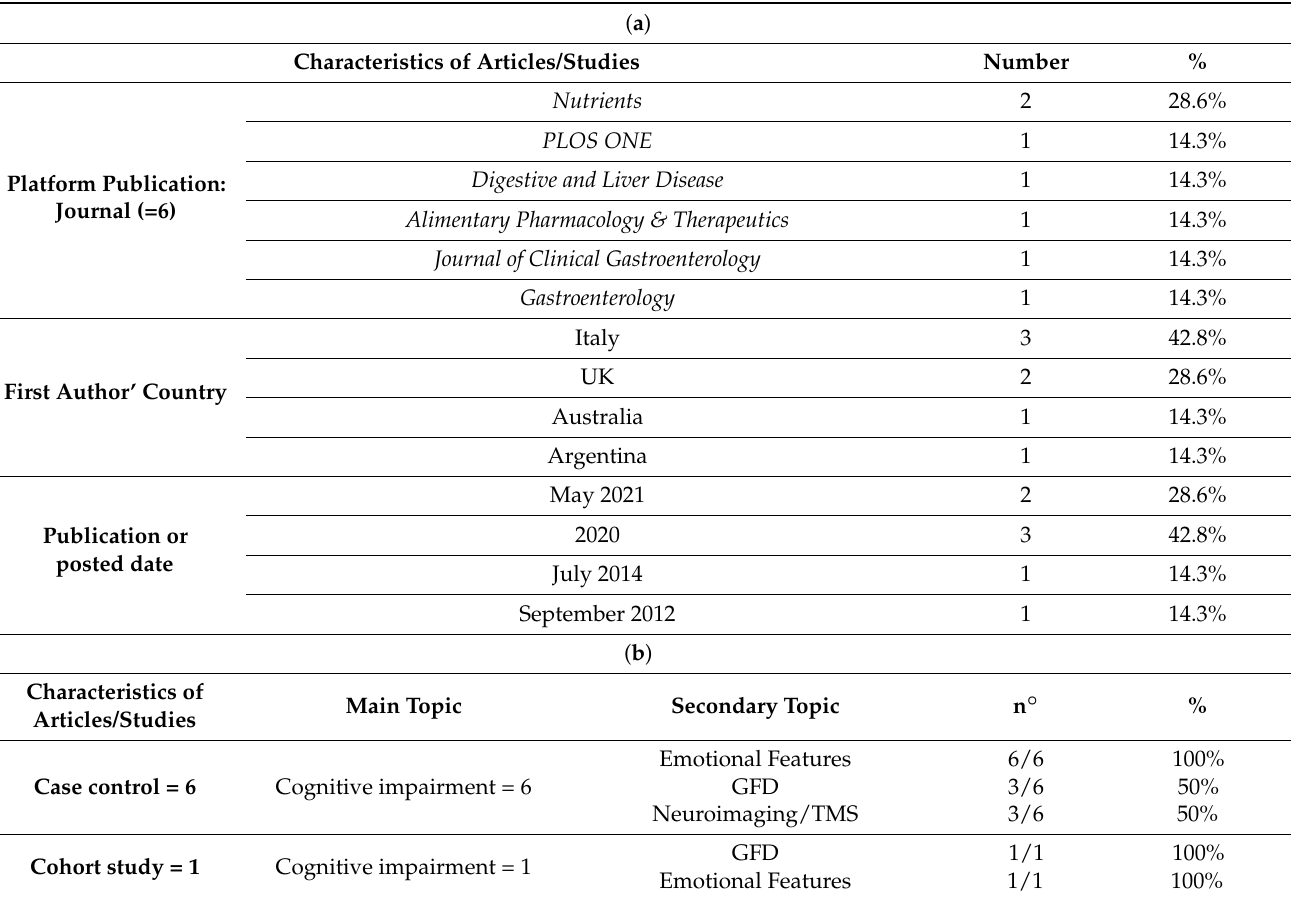
Table 1. ( a ) Publishers of articles/studies. ( b ) Characteristics of celiac disease-associated cognitive impairment